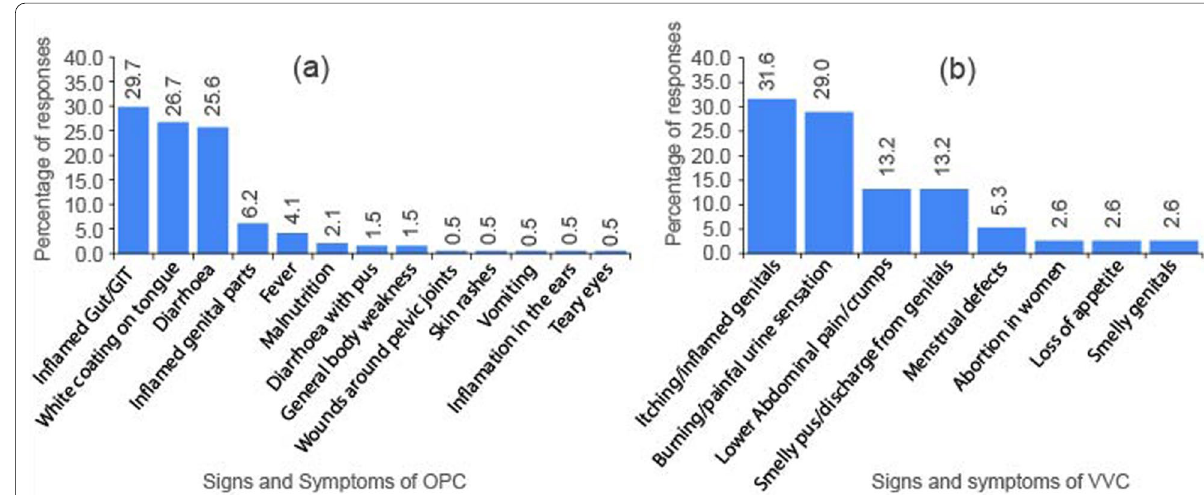
Fig. 3 Signs and symptoms of oropharyngeal candidiasis ( a ) and vulvovaginal candidiasis ( b )